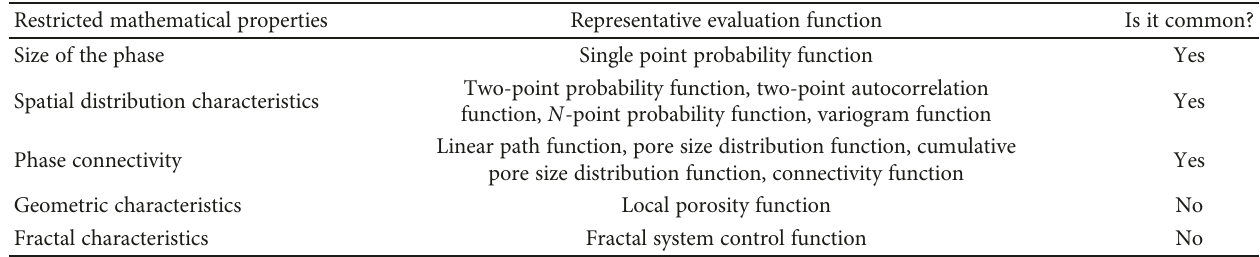
Table 4: List of evaluation functions of digital